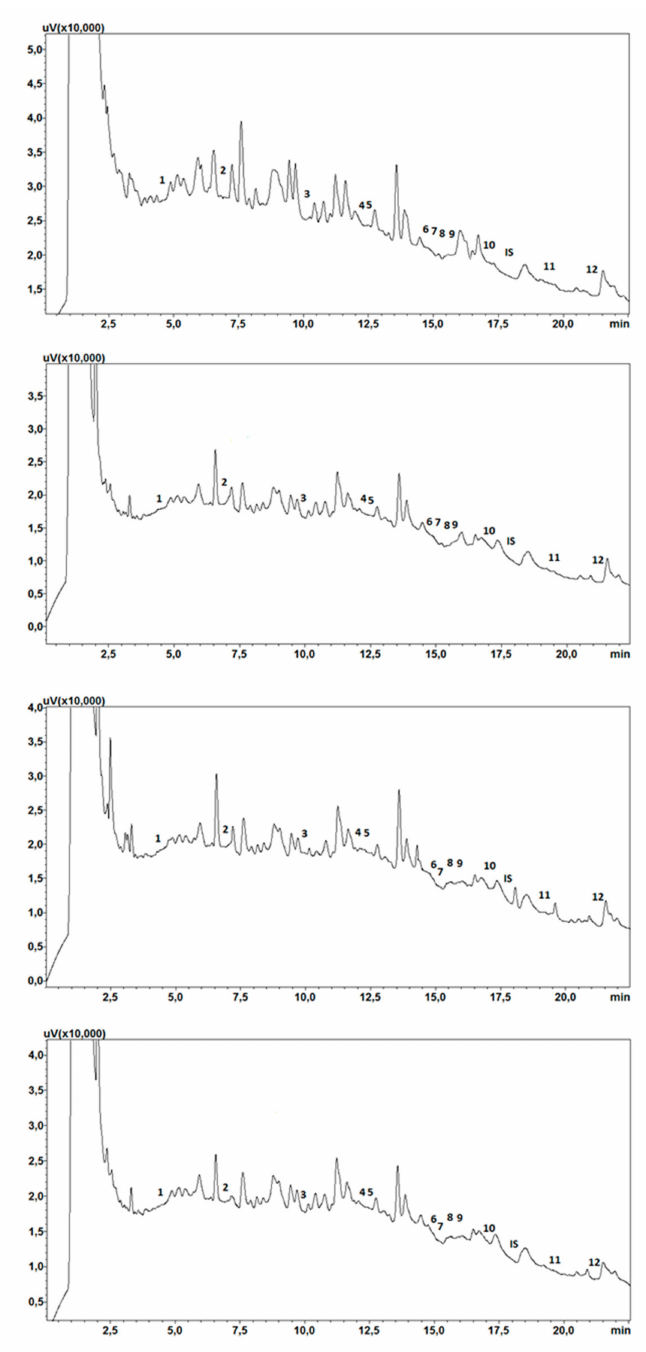
Figure 5. Chromatogram of saliva sample extracts obtained from 4 healthy donors.